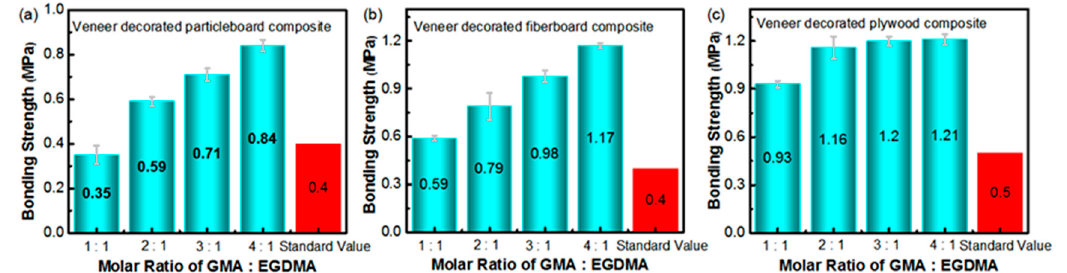
Figure 1. Optimization of the monomers reaction ratio of the three wood-based panel composites: ( a ) The veneer-decorated particleboard composite; ( b ) the veneer-decorated fiberboard composite; ( c )